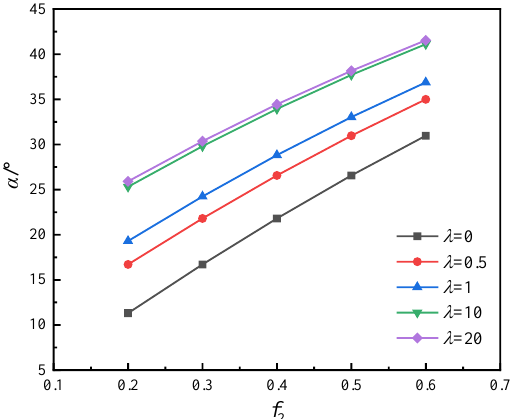
Figure 10. Relationship between limit angle α and support – floor friction f 2 .